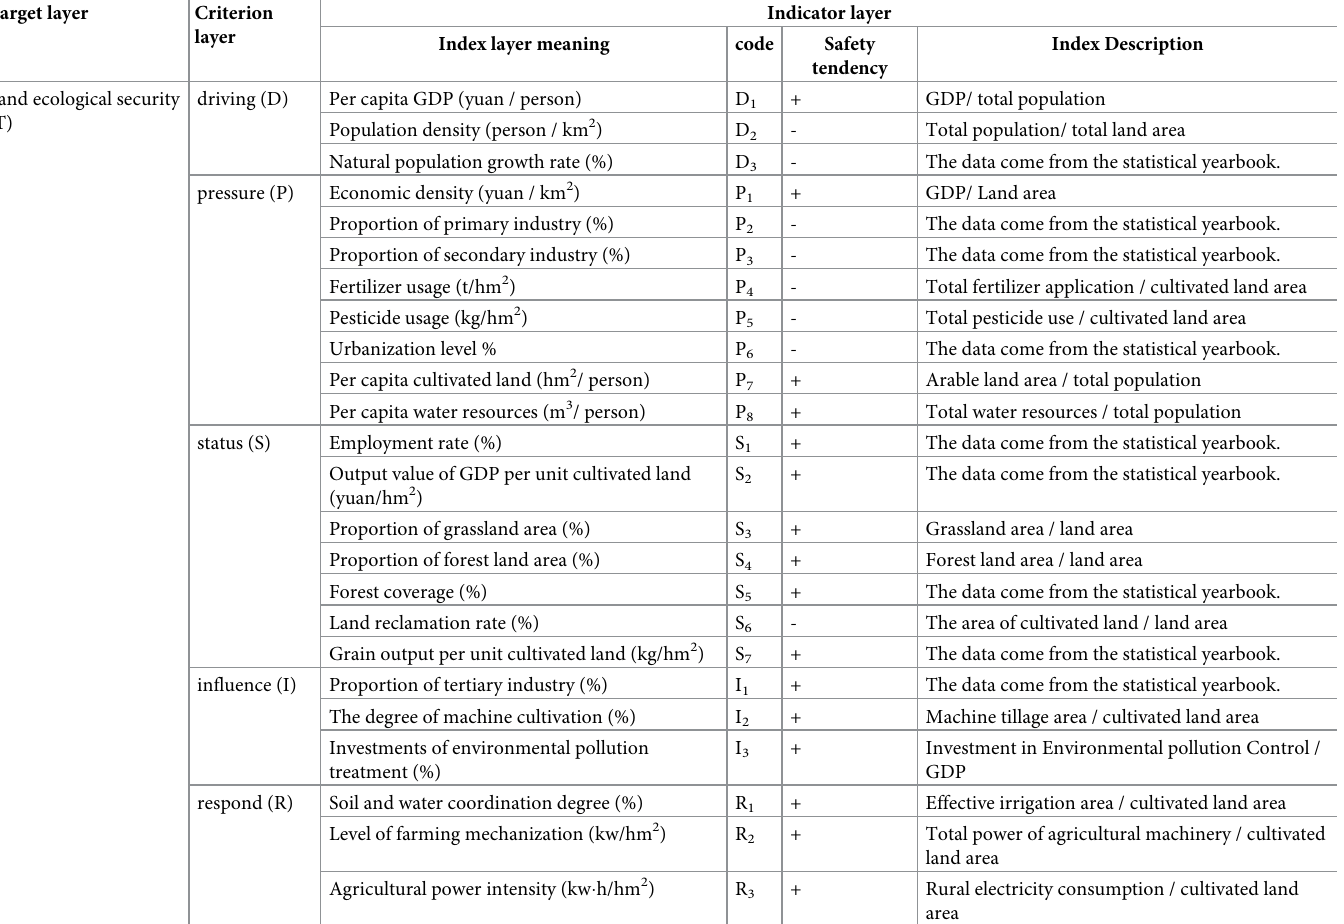
Table 1. Land-based ecological security evaluation index system for in Xingtai city. Target